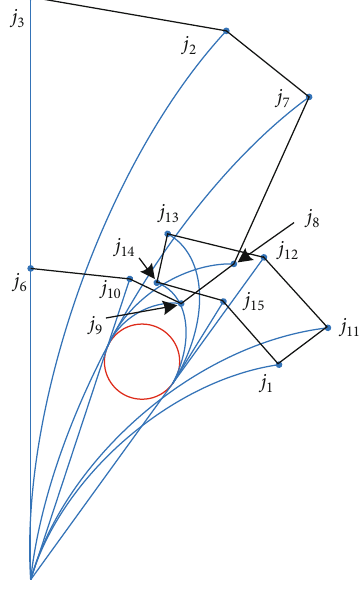
Figure 10: Landing footprints for Case